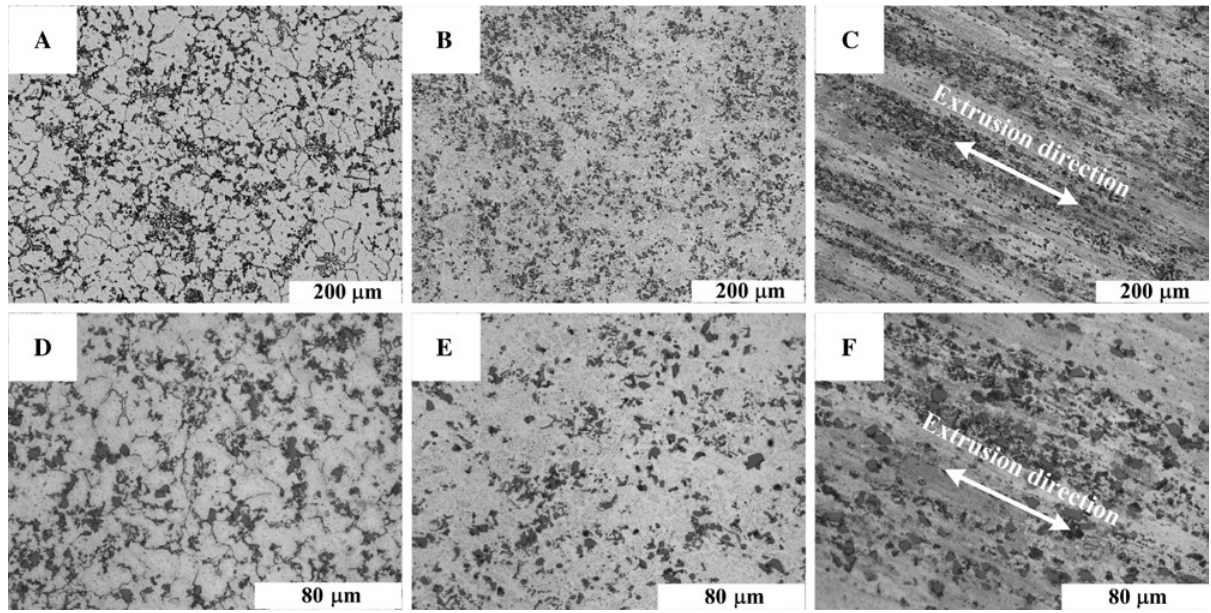
Figure 1: (A) SiC particles and (B) corresponding XRD pattern and the SEM micrographs of (Al2014-SiC at (C) low and (D) high magnification.